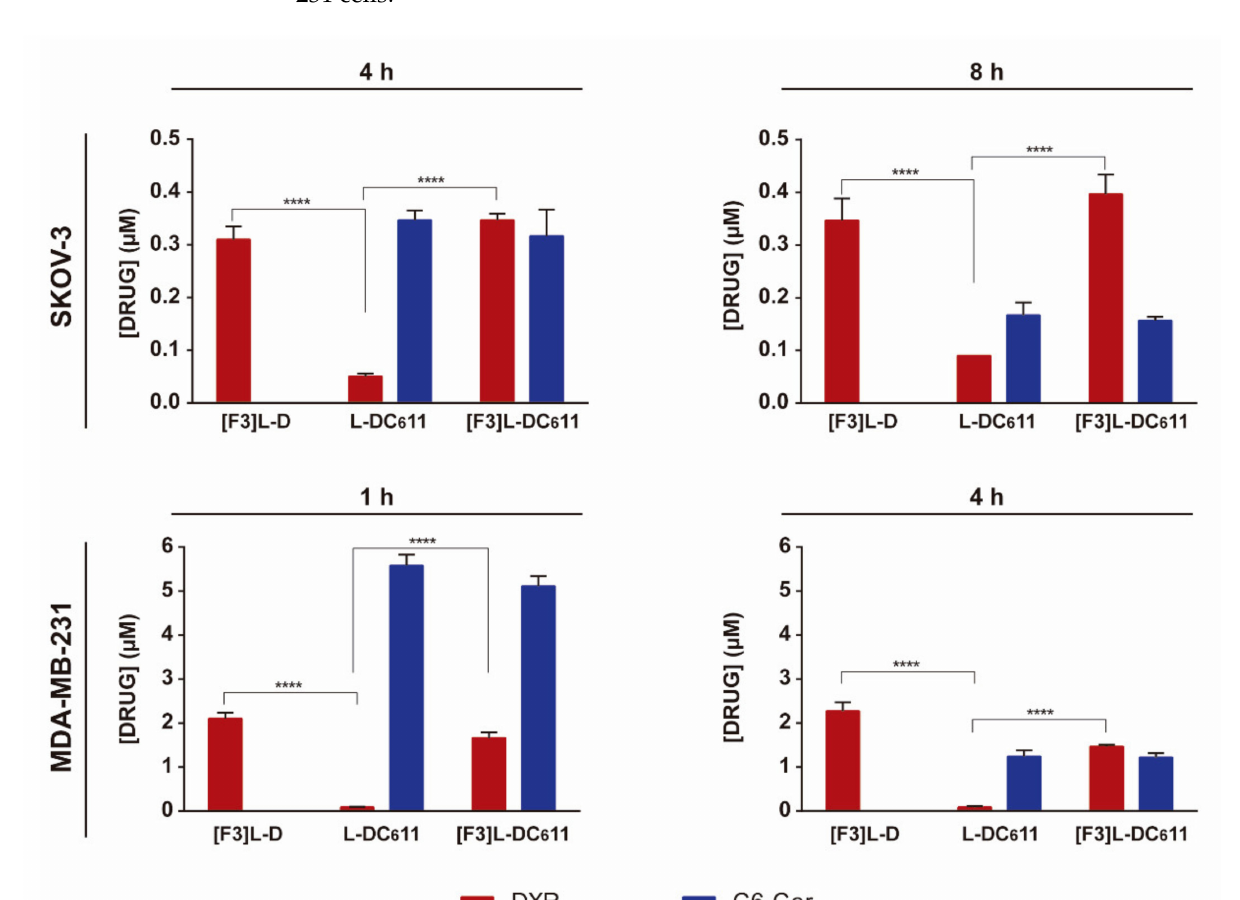
Figure 5. Quantification of intracellular doxorubicin and C6-ceramide by mass spectrometry. Cells were incubated with previously determined DXR concentrations corresponding to the lowest IC 50 of the [F3]L-DC 6 11 formulation. SKOV-3 cells were incubated with 0.63 and 0.49 µ M for 4 and 8 h, respectively, and MDA-MB-231 with 25.87 and 6.35 µ M for 1 and 4 h, respectively, at 37 ◦ C with F3 peptide-targeted liposomal DXR ([F3]L-D) or DXR:C6-ceramide combination at a molar ratio of 1:1 ([F3]L-DC 6 11) or the non-targeted counterpart (L-DC 6 11). DXR and C6-ceramide were quantified after extraction from the cultured cells. Data represent the mean ± SEM ( n = 3; two-way ANOVA with Tukey’s multiple comparisons post-test; **** p <